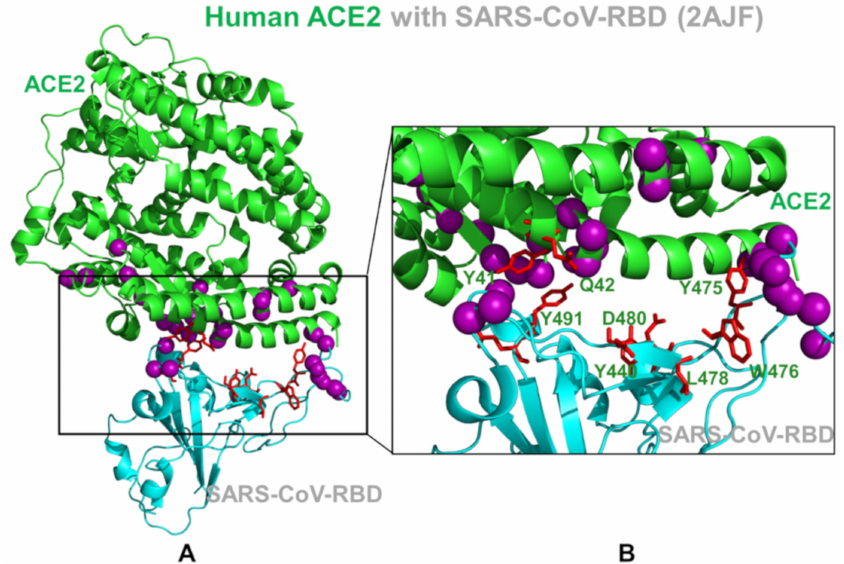
Figure 6. Structural mapping of the SARS-CoV-RBD and ACE2 residues with high pMI and cMI values. ( A ) A general overview of the SARS-CoV-RBD complex with ACE2. The high pMI residues serving as regulators of coevolutionary network are shown in pink spheres. The highly coevolving residues with high cMI values are shown in red sticks. Note a consolidation of regulatory high pMI sites in the central segment of the binding interface and clusters of highly coevolving residues near the flexible loop regions of the binding interface. ( B ) A close-up of the binding interface between SARS-CoV-RBD and ACE2. The high pMI residues (pink spheres) and high cMI residues (red sticks) are shown and annotated for the key positions that control coevolutionary couplings in the